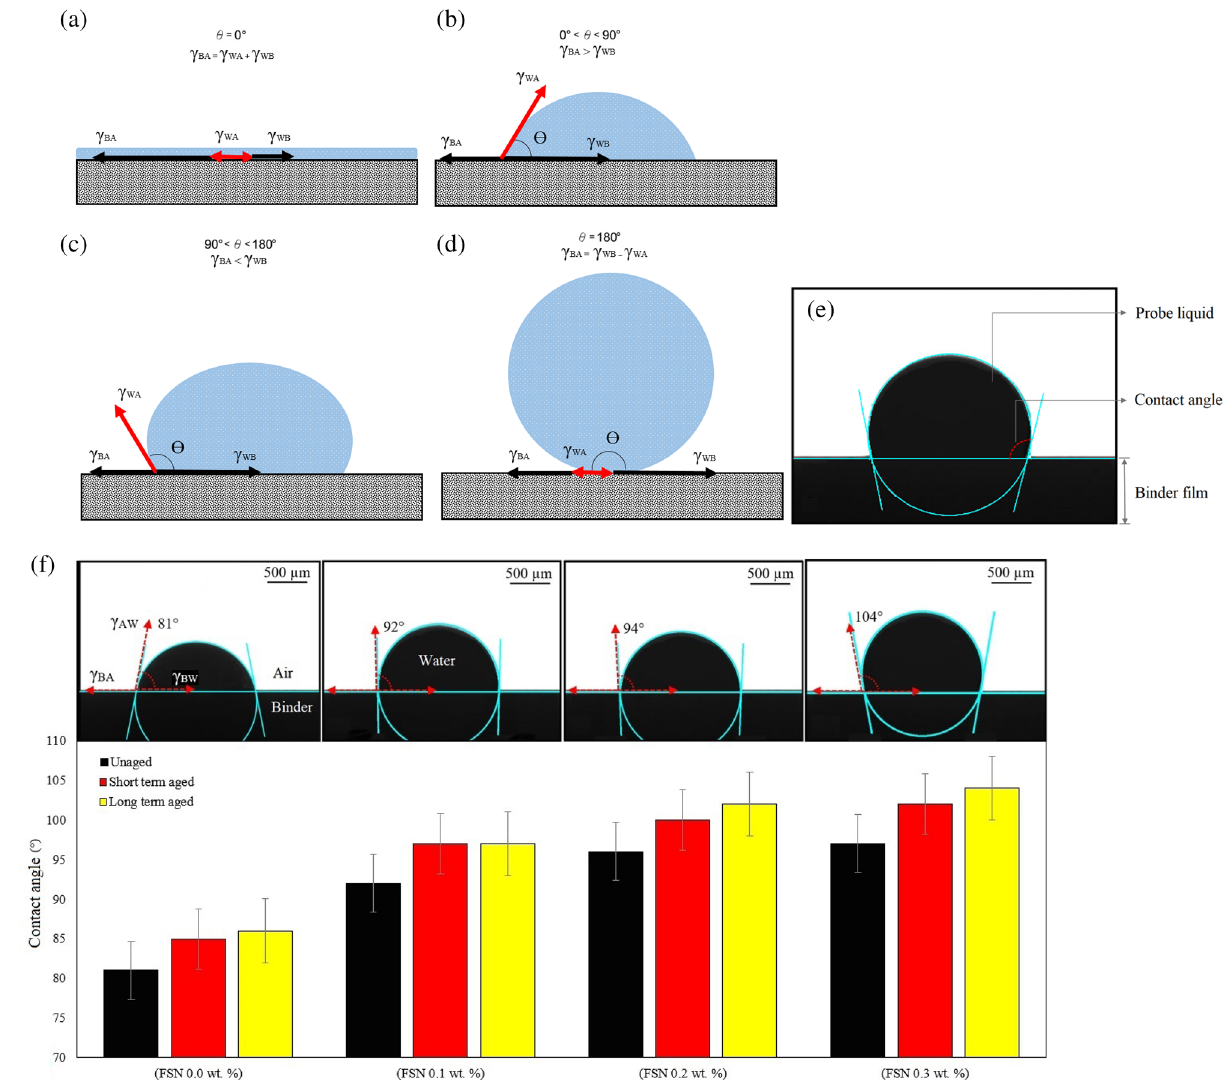
Figure 10. Schematic diagrams of different surface wettability situations: ( a ) absolute wetting (super hydrophilic), ( b ) high wetting, ( c ) low wetting, ( d ) absolute non-wetting (super hydrophobic), and ( e ) a liquid droplet on asphalt binder film. ( f ) Contact angles of modified binders in different concentrations of fumed silica nanoparticles. Interface energy of binder-water is denoted by γ BW , solid surface energy of binder-air by γ BA , liquid surface energy of air–water by γ AW